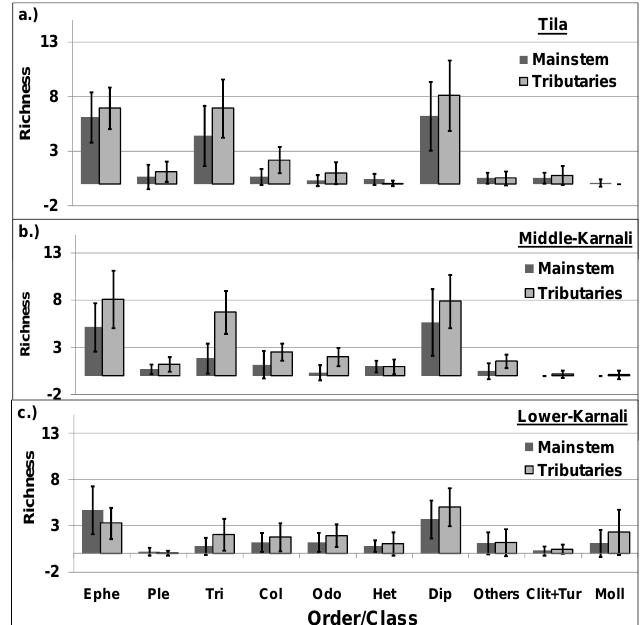
Figure 4. Benthic macroinvertebrate taxa richness across different taxonomic groups in the river’s mainstem and tributaries of the studied watersheds ( a . Tila, b . Middle-Karnali, c . Lower-Karnali ) . Ephe: Ephemeroptera, Ple: Plecoptera, Tri: Trichoptera, Col: Coleoptera, Odo: Odonata, Het: Heteroptera, Dip: Diptera, Others: Decapoda, Megaloptera and Lepidoptera, Clit+Tur: Clitellata+Turbellaria; Moll: Mollusca.